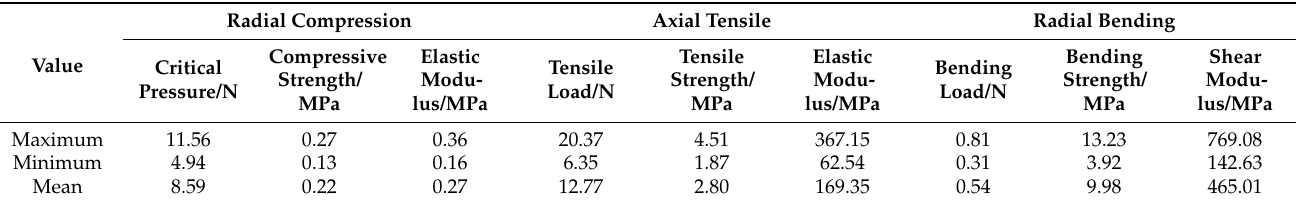
Figure 4. Compression curve of hairy vetch stalk.